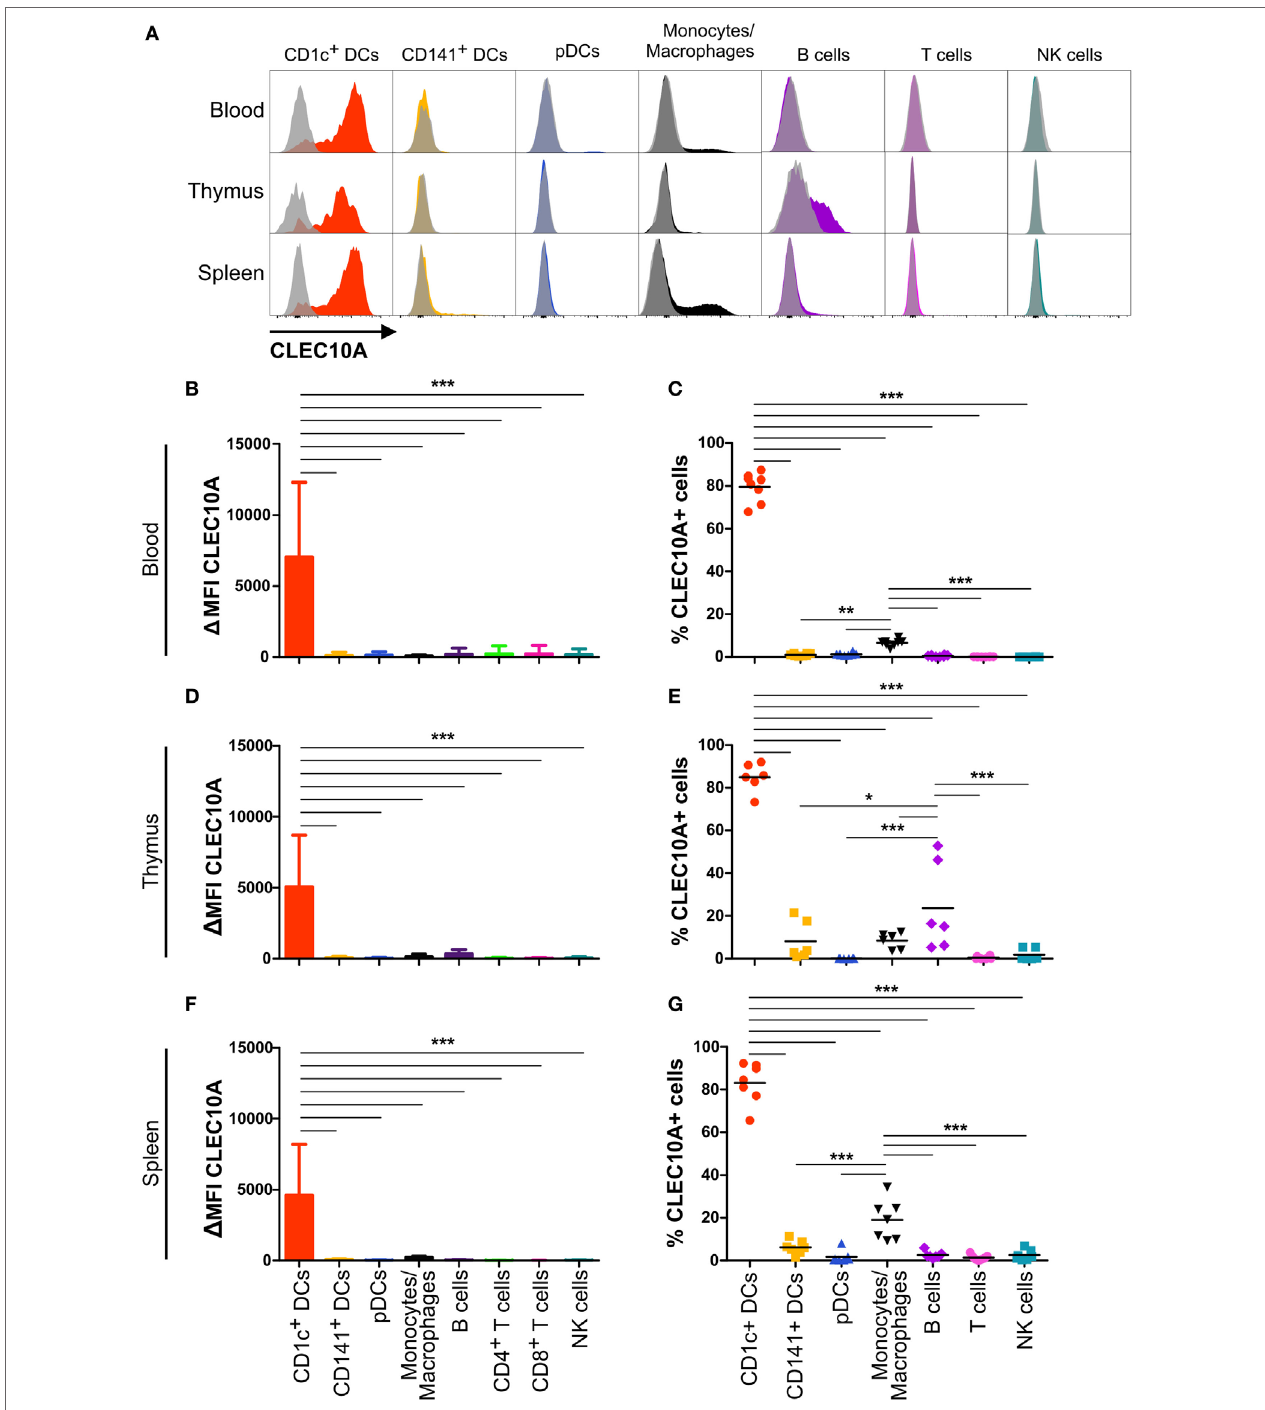
FigUre 2 | CLEC10A is mainly expressed on human CD1c + dendritic cells (DCs) in different tissues in the steady state. The expression of CLEC10A was analyzed by flow cytometric analysis on human DC subpopulations in blood, thymus, and spleen. (a) Depicted are overlay histograms of single cell suspensions of one representative donor each of blood, thymus, and spleen analyzed by flow cytometry for an anti-CLEC10A antibody (colored) and appropriate isotype control (gray, transparent). Bar graphs in (B,D,F) show the Δ MFI for CLEC10A (median ± SD, blood n = 8; thymus n = 6; spleen n = 7). (c,e,g) In each leukocyte population, the CLEC10A + cells were determined using an appropriate isotype control and plotted as a scatter plot with mean as horizontal line. Significant differences in the (B,D,F) expression of CLEC10A or (c,e,g) percentages of CLEC10A + cells were calculated by one-way ANOVA with Bonferroni posttest using GraphPad Prism (* p < 0.05, ** p < 0.01, and *** p < 0.001).